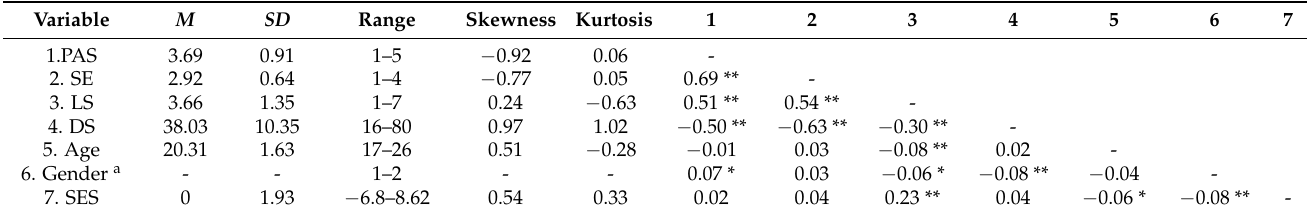
Table 3. Descriptive statistics and bivariate correlations between variables in Study 2.